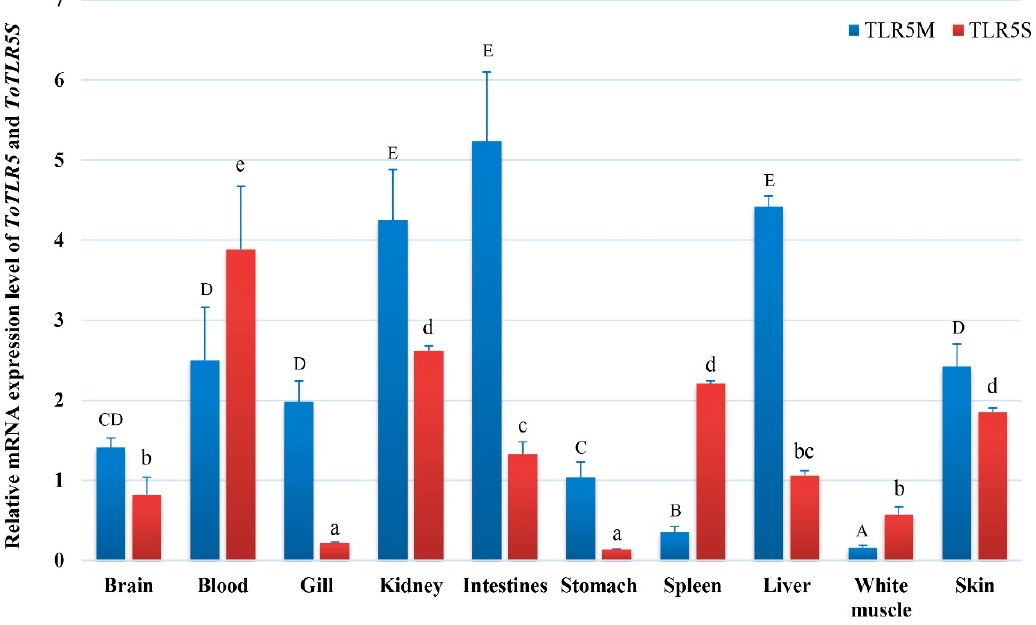
Figure 3. The tissue expression of the ToTLR5M and ToTLR5S genes. The tissues included kidney, liver, stomach, spleen, intestine, brain, skin, gill, muscle, and blood. Elongation factor 1 alpha ( EF-1 α ) acted as an internal reference to calibrate the cDNA templates. Mean ± standard error (SE) ( n = 3) of each mRNA quantity was shown for each tissue examined. Different uppercase or lowercase letters indicate significant differences ( p < 0.05).